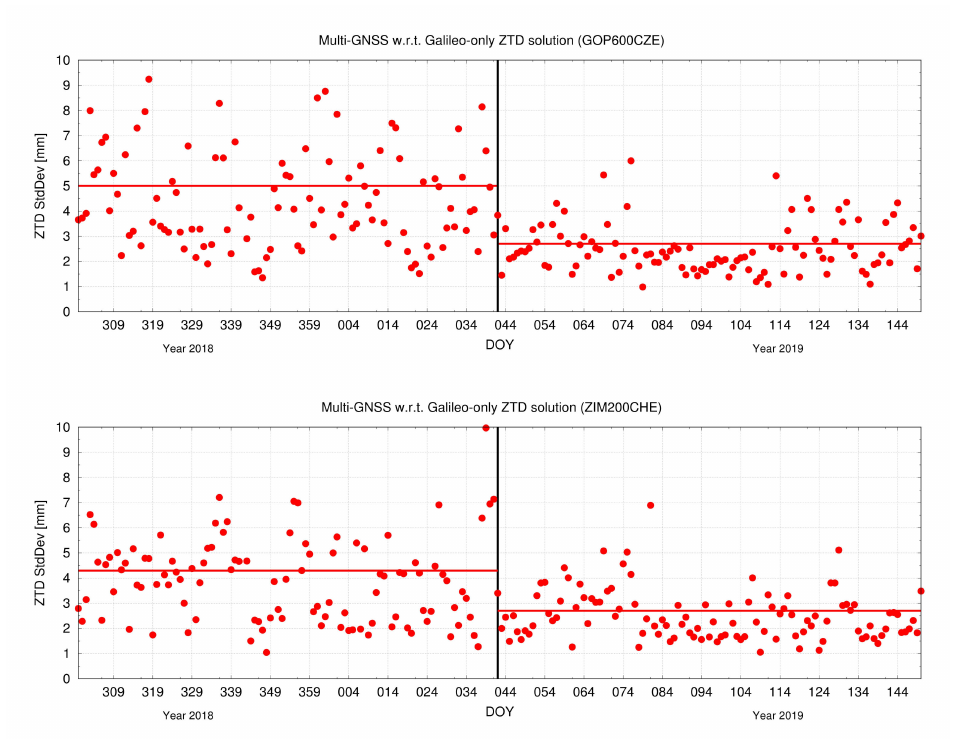
Figure 3. Variations of Galileo troposphere ZTDs for stations ZIM2 (top) and GOP6 (bottom) from October 27, 2018 (Day Of Year (DOY) 300), to May 30, 2019 (DOY 150).